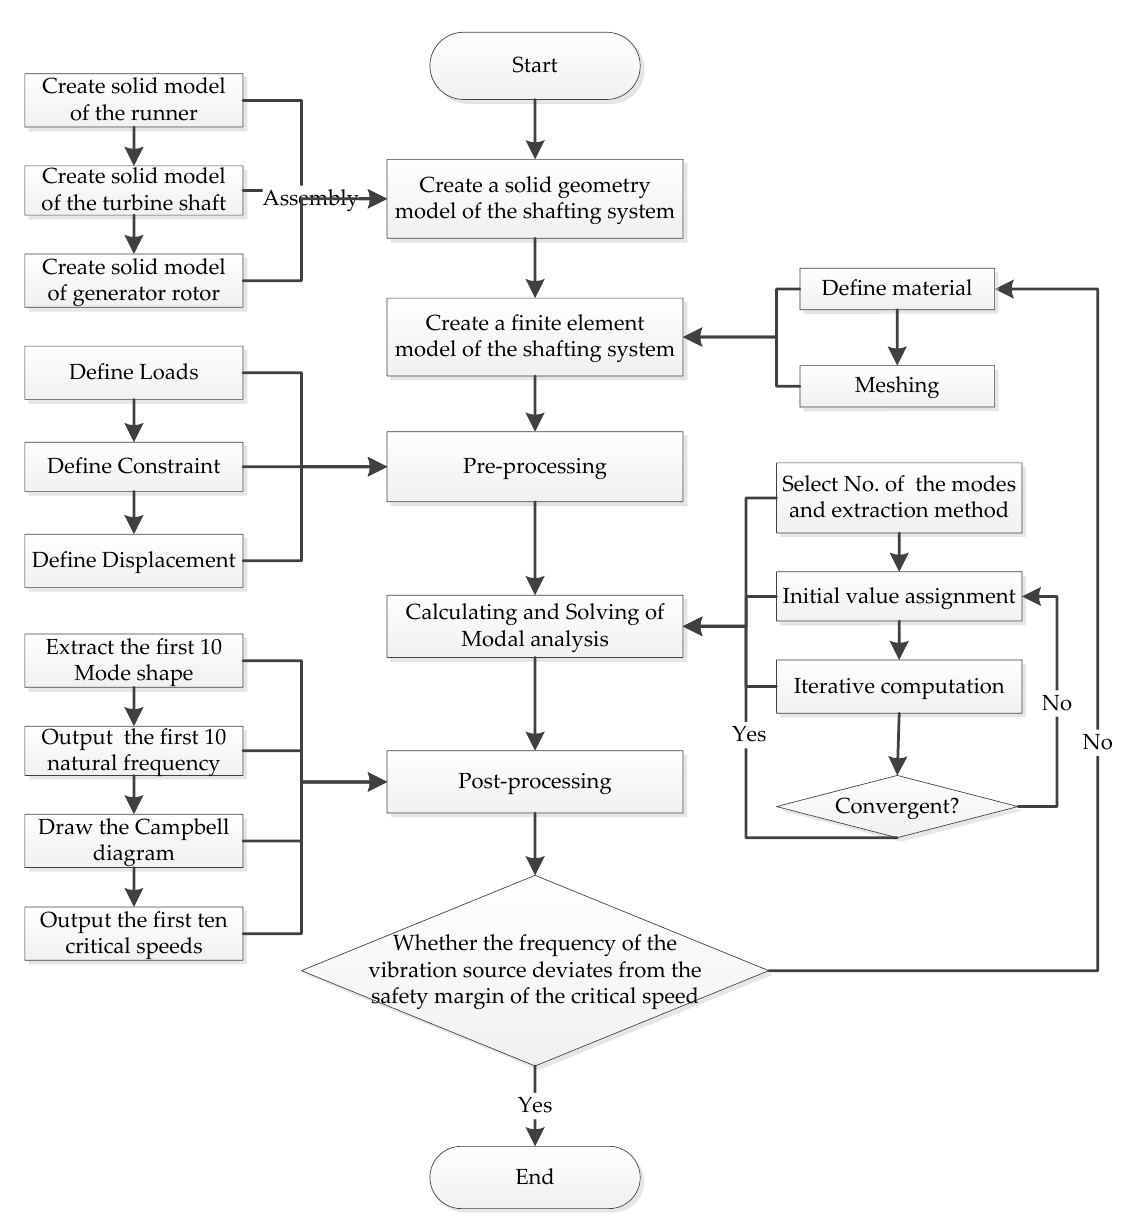
Figure 1. Flow chart of Finite element modal analysis method.